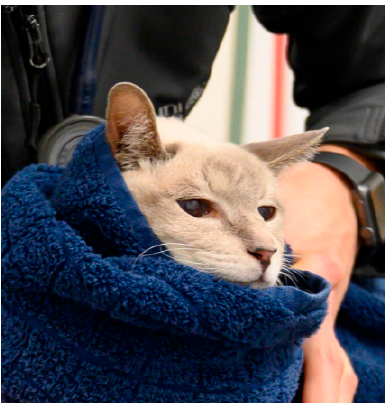
Figure 6. Towels and blankets can be used in various ways for safe restraint of cats and small dogs. Photo: Christine Arhant, Vetmeduni Vienna.